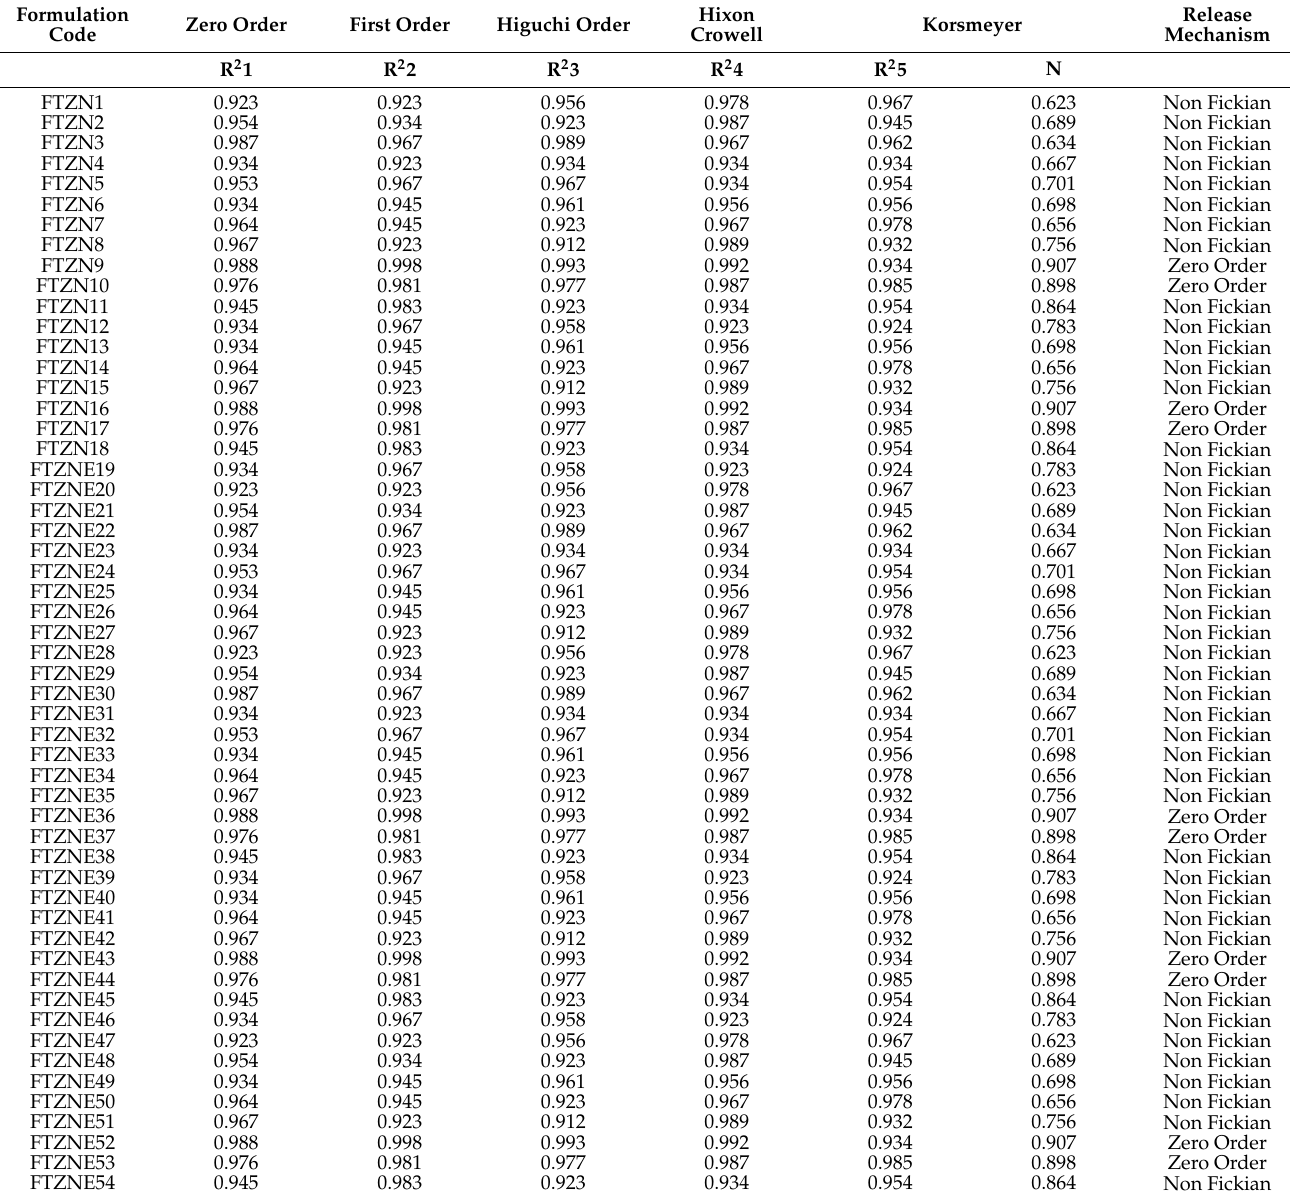
Table A2. Controlled release patches of tizanidine containing different ratios of C: TC, EC: PVP and Eudragit: PVP. Formulation